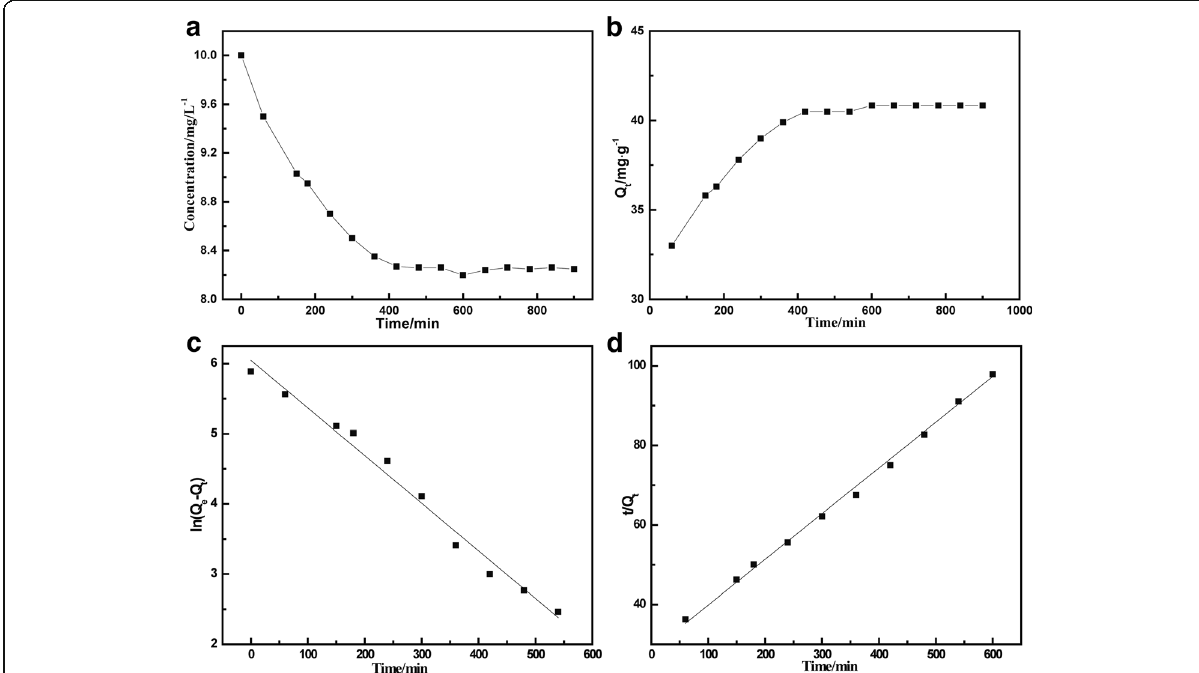
Fig. 4 TC adsorption kinetics of MnFe 2 O 4 /rGO nanocomposite. a TC concentration and ( b ) adsorption capacity versus time during adsorption, and adsorption kinetics fitted with ( c ) pseudo-first-order kinetic model and ( d ) pseudo-second-order kinetic